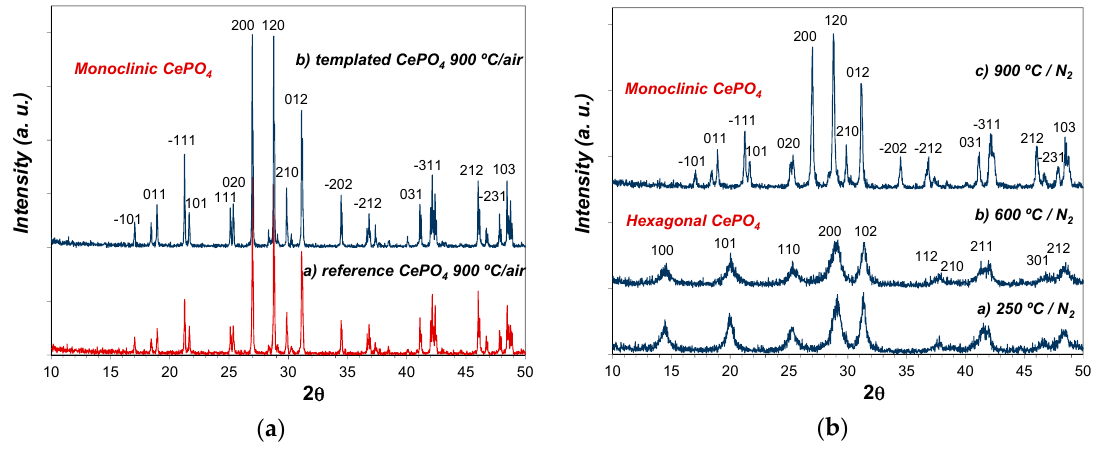
Figure 9. ( a ) XRD patterns of: non-templated reference CePO 4 (a); and C12GA-templated CePO 4 (b) after annealing treatment at 900 ◦ C under air atmosphere; ( b ) XRD patterns of templated CePO 4 after subsequent annealing treatments at: 250 ◦ C (a), 600 ◦ C (b), and 900 ◦ C (c) under N 2 atmosphere. As an additional experiment, the pristine C12GA-templated CePO 4 sample (60 ◦ C) was